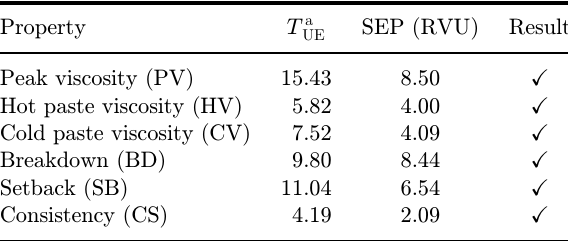
Table 3. The statistic test of the signi¯cance of bias for model performance.